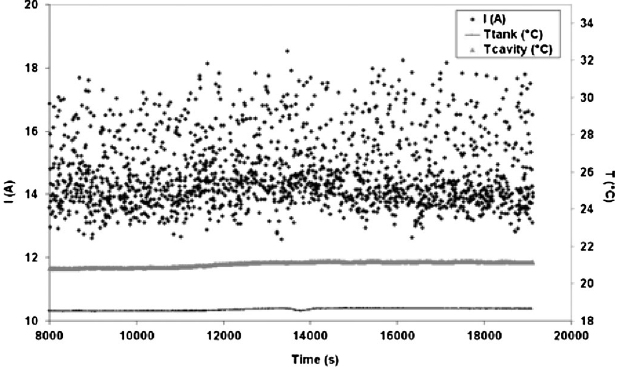
LV-EP.FIG. 10. Current intensity and temperature vs time for the C1- 21 cavity during LV-EP (5.4 V). A characteristic current insta- bility is observed. The electrolyte temperature is very